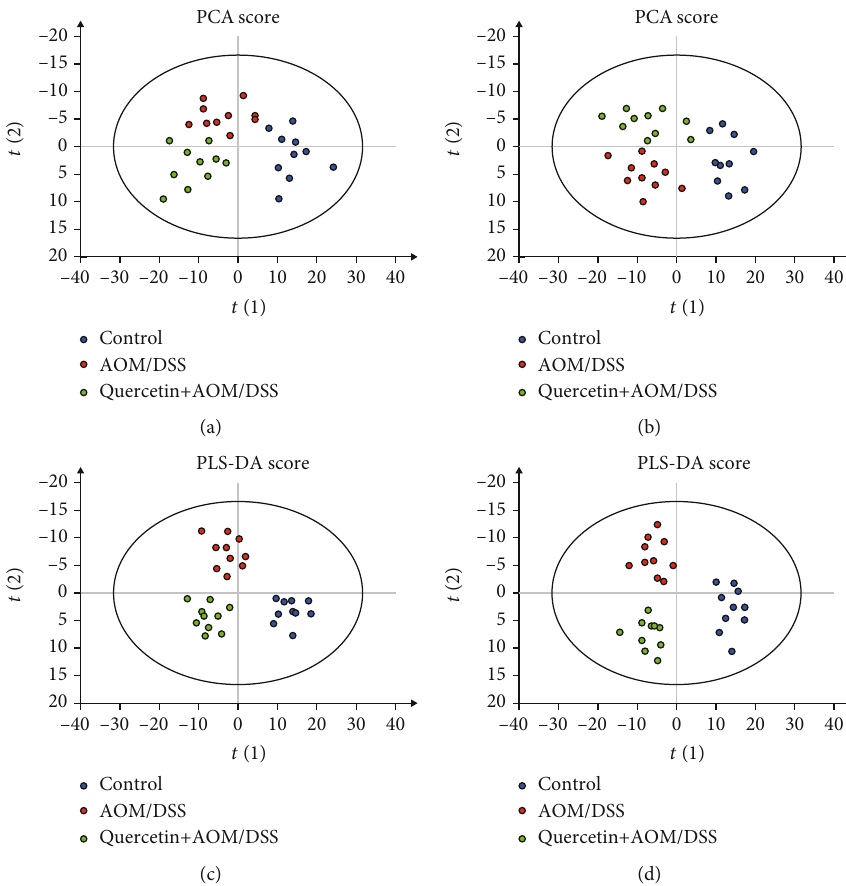
Figure 7: Quercetin alters serum metabolites in AOM/DSS-treated mice. (a) PCA score from serum in positive mode. (b) PCA score from serum in negative mode. (c) PLS-DA score from serum in positive mode. (d) PLS-DA score from serum in negative mode. n = 10 per group. Table 1: Metabolite pro fi ling in the serum from the control, AOM/DSS, and quercetin+AOM/DSS groups. Control vs. Control vs. AOM/DSS